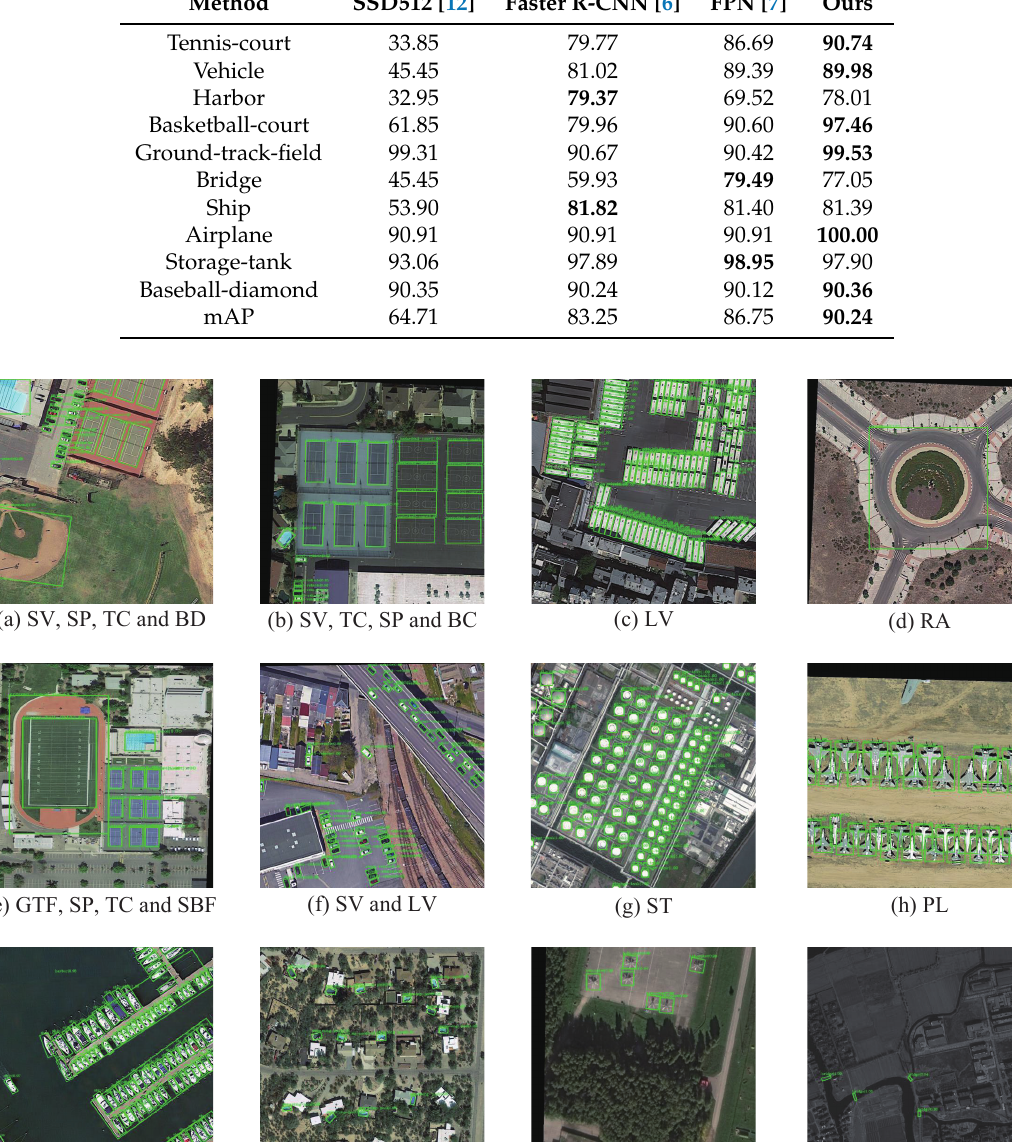
Table 3. Overall performance evaluation of different methods on NWPUVHR-10 datasets. Bold numbers in Tables means the best results.